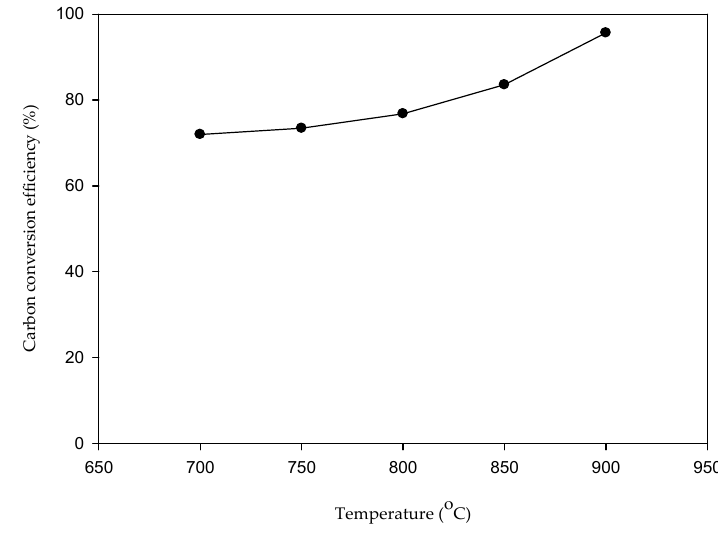
Figure 4. Carbon conversion efficiency with respect to temperature.